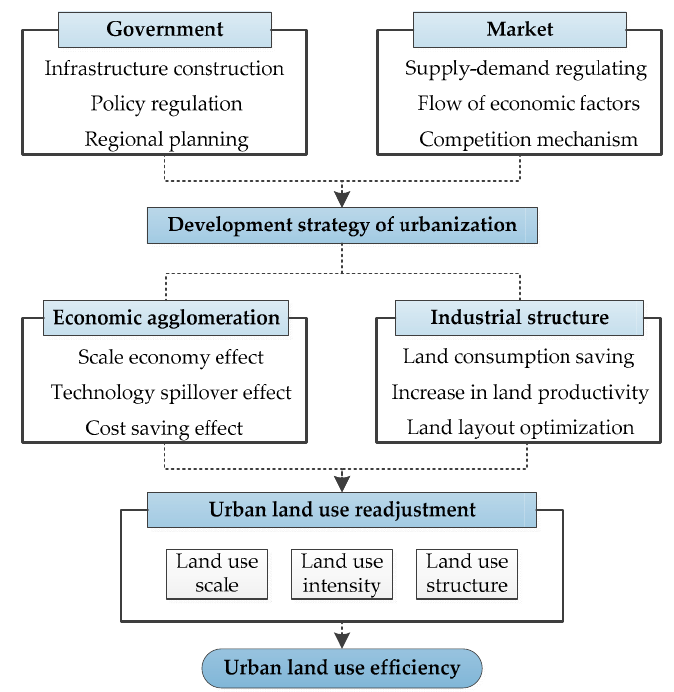
Figure 1. Theoretical analysis of new type of urbanization and ULUE.